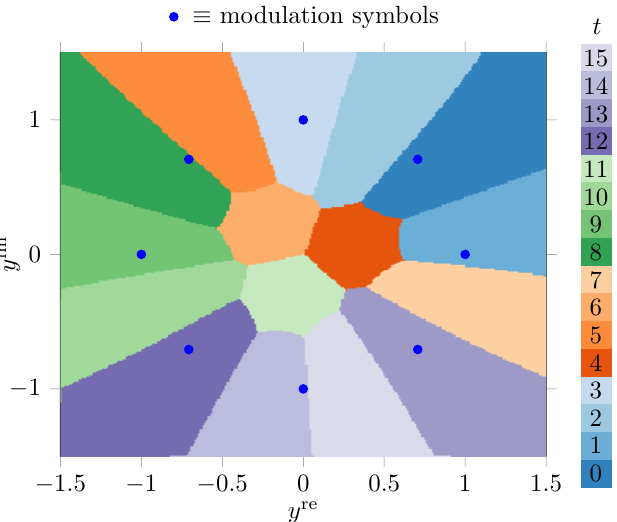
Figure 6. Quantization regions for the output of an AWGN channel with 8-PSK modulation in the = 16 constructed with the KL-means algorithm. I ( X ; Y ) complex plane for σ 2 n = 0.5, |T | bit, I ( X ; T ) 1.38887 bit. ≈